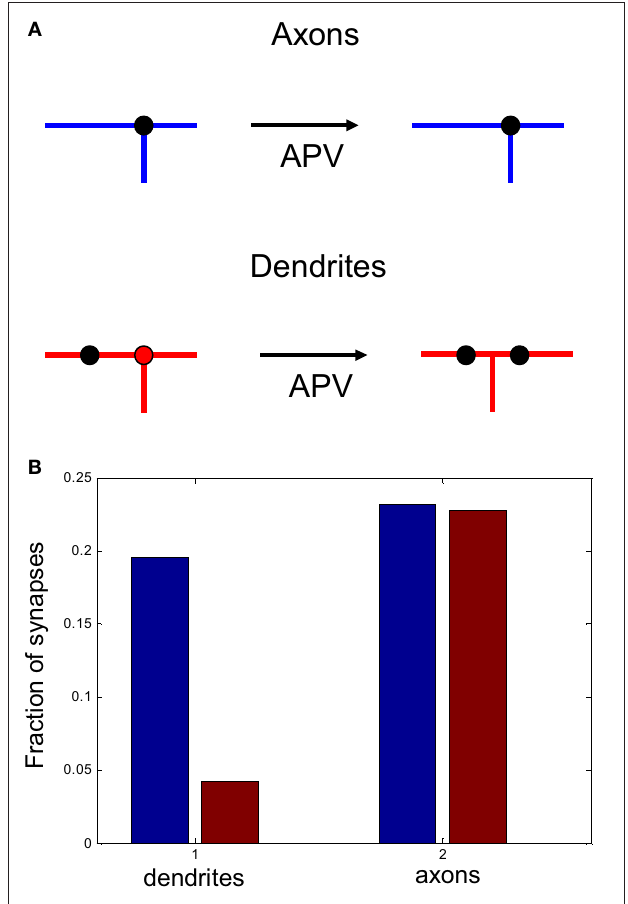
FIGURE 8 | The role of activity block on the spatial correlations between branch points and synapses. (A) Schematic representation of the predictive capacity of the model. If axons implement an activity-independent synaptotropic branching strategy and dendrites implement Hebbian branching strategy, the consequences of activity blockade are different for axons and dendrites. The spatial correlations between synapses and branch points remain unchanged for axons, and are reduced for dendrites after an NMDAR antagonist is applied. (B) The fraction of synapses located at branch points before (blue) and after (red) activity block in the simulation, when axons and dendrites implement optimal branching